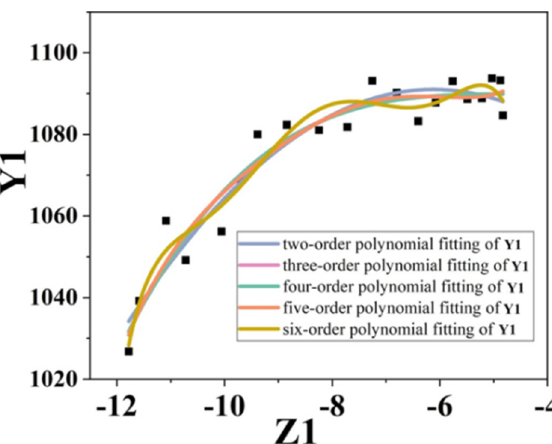
Figure 2. Five different polynomial fitting curves for RPM(Z) and EGT1(Y1).